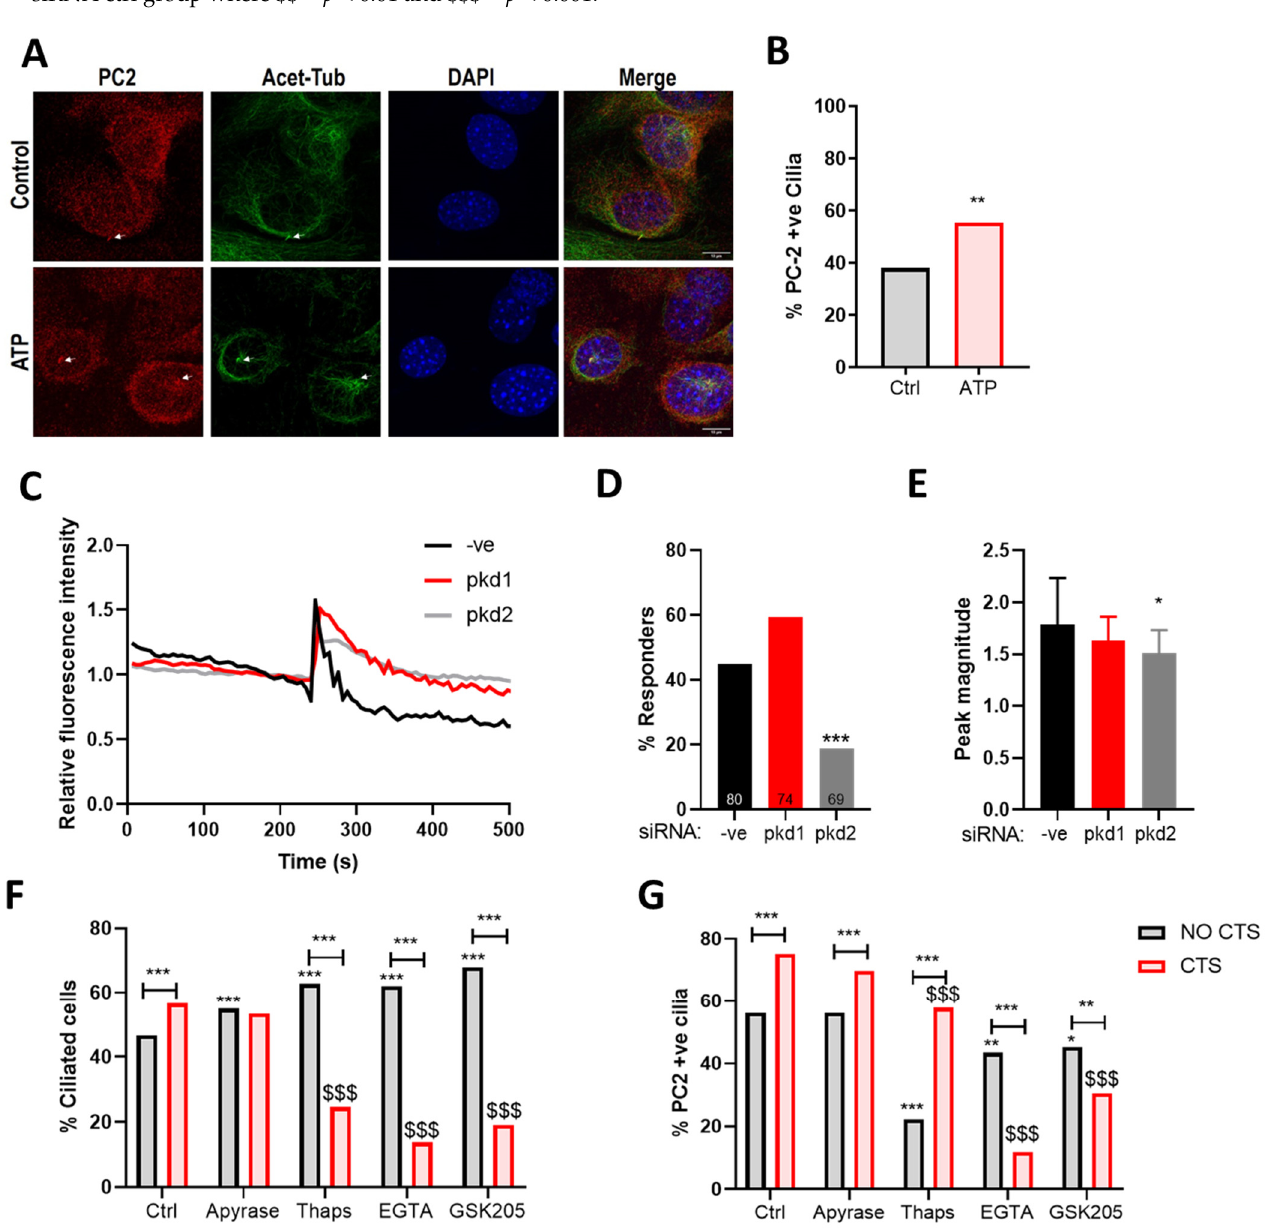
Figure 4. Polycystin-2 ciliary localization is increased in response to strain. Bovine articular chondrocytes were cultured on elastomeric membranes and subjected to 10% cyclic tensile strain (CTS) for 1, 6, and 24 h at 0.33 Hz. ( A ) Chondrocytes were immunolabeled for polycystin-2 (PC2, red), primary cilia were labeled for acetylated α -tubulin (acet-tub,green) and nuclei were counterstained with DAPI (blue). Scale bar = 10 µm. ( B ) Cilia length ( n = 48 fields, two-way ANOVA), ( C ) cilia prevalence ( n > 800 cells, chi-squared test), and ( D ) the proportion of PC2-positive cilia ( n > 600 cells, chi-squared test) were quantified. Immortalized murine chondrocytes were transfected with -ve control and pkd1 siRNA was then subjected to 10% CTS for 1 h. ( E ) The proportion of ciliated cells ( n > 500 cells, chi squared test) and ( F ) cilia length were quantified ( n > 48 fields, two-way ANOVA). ( G ) Chondrocytes were immunolabeled for PC2 (red) and acet-tub (green), and the proportion of PC2 positive cilia was quantified ( n > 200 cilia, chi squared test). Significance is displayed relative to the unstrained control as: * = p < 0.05, ** = p < 0.01 and *** = p < 0.001 whereas $ denotes significance relative to the CTS -ve siRNA ctrl group where $$ = p < 0.01 and $$$ = p < 0.001.